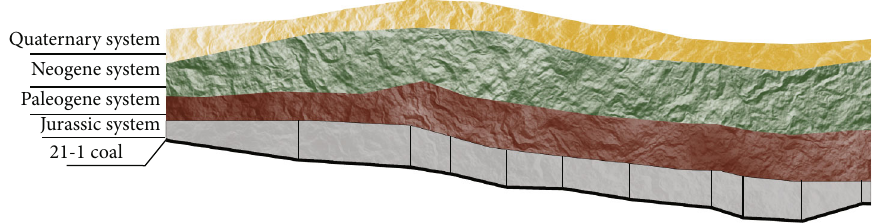
Figure 1: The distribution from the coal seam to Quaternary strata